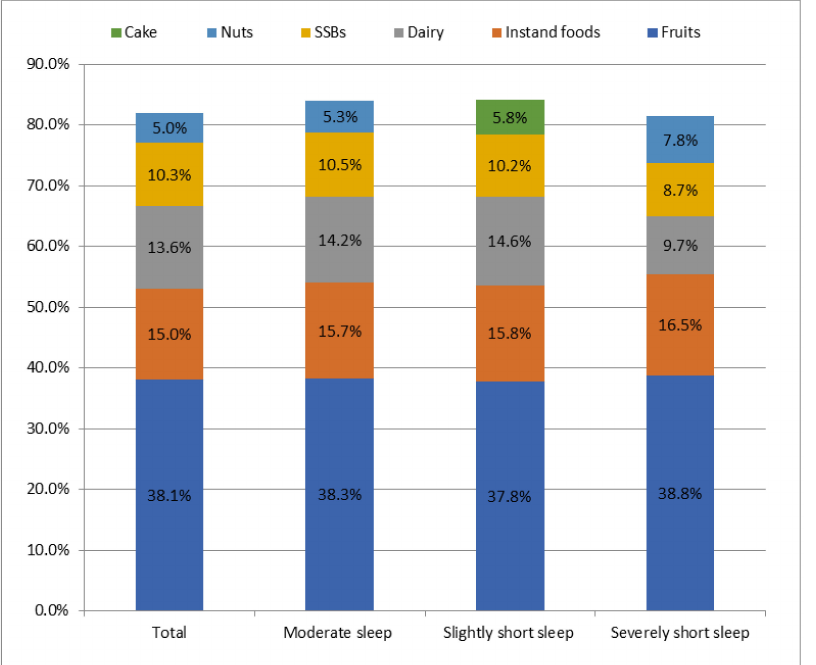
Figure 1. The top 5 snack types with highest consumption rate in children with different sleep durations.